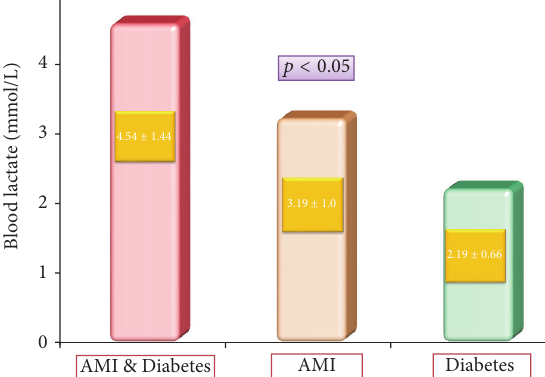
Figure 2: Mean blood lactate levels in patients with acute myocar- dial infarction and diabetes mellitus (AMI & Diabetes) and patients with acute myocardial infarction and normal glucose metabolism